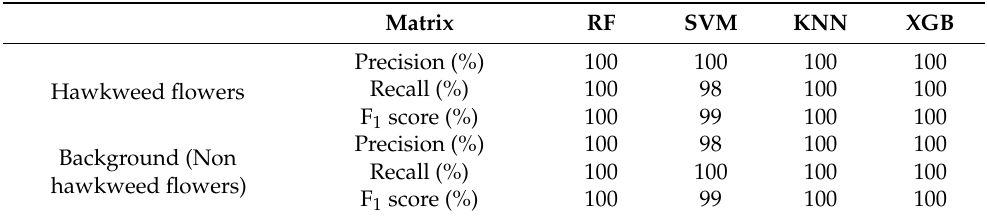
Table 5. Classification report (testing) of different machine learning models for detection of hawkweed flowers at 0.65